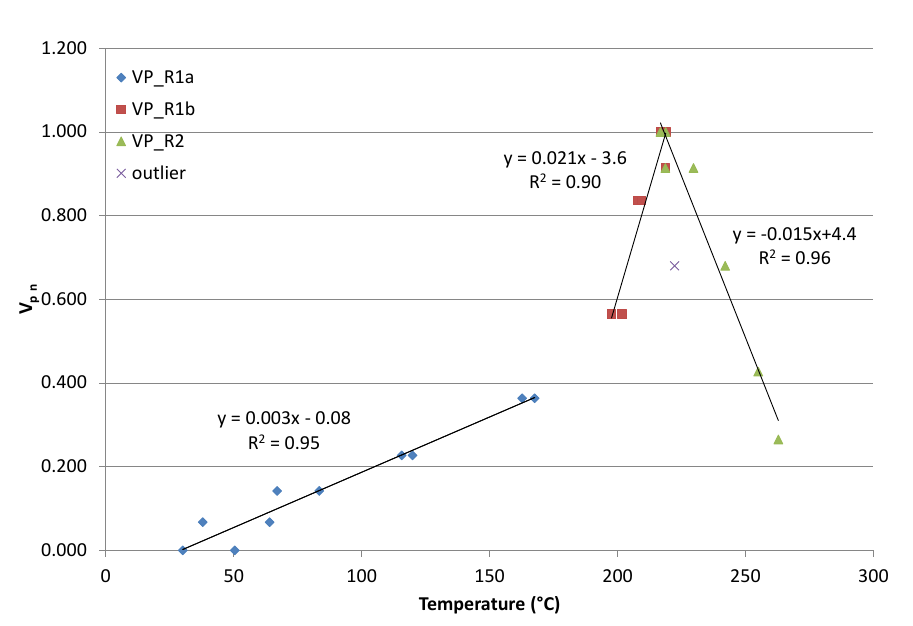
Figure 7. Correlation plot for normalised seismic velocity anomaly ( V pn ) and reservoir temperature. Data for wells MON-1 and MON-2 are combined. Three different correlation regimes (R1a, R1b and R2) are suggested by the data. One point has been rejected as an outlier. This point which relates to the bottom of well MON-1 is thought to be slightly